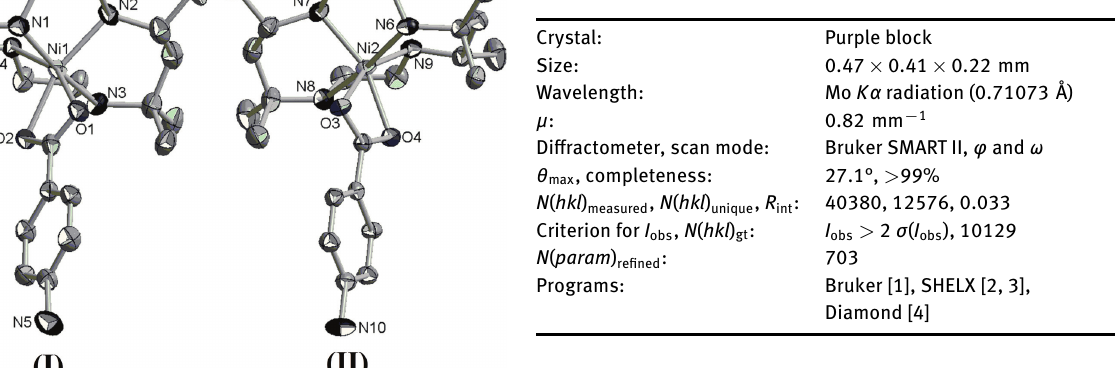
Table 1: Data collection and handling.